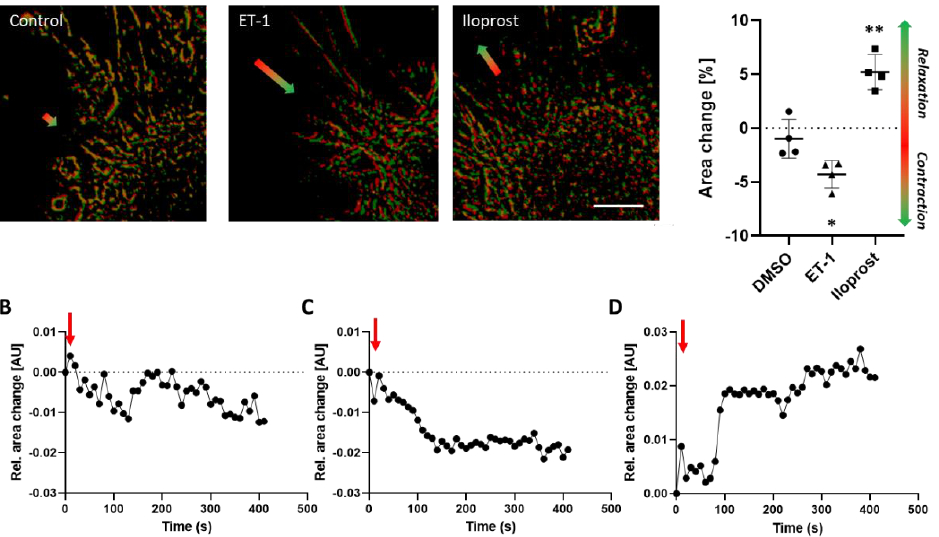
Figure 5. Contraction and relaxation of human umbilical artery smooth muscle cells (HUASMCs).